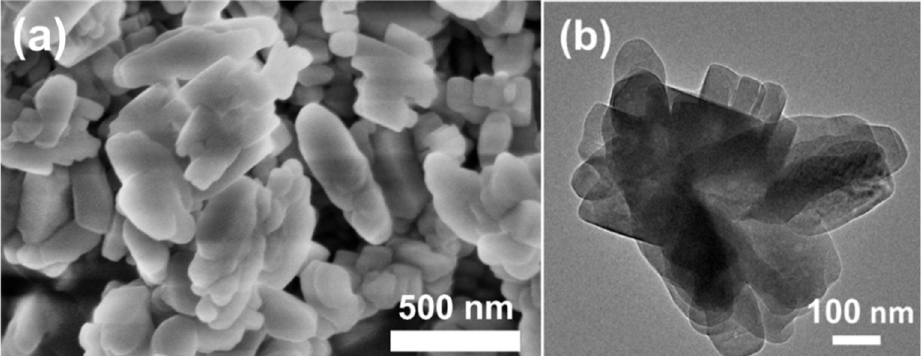
Figure 6. ( a ) SEM and ( b ) TEM micrographs of Z5-PK3-free.